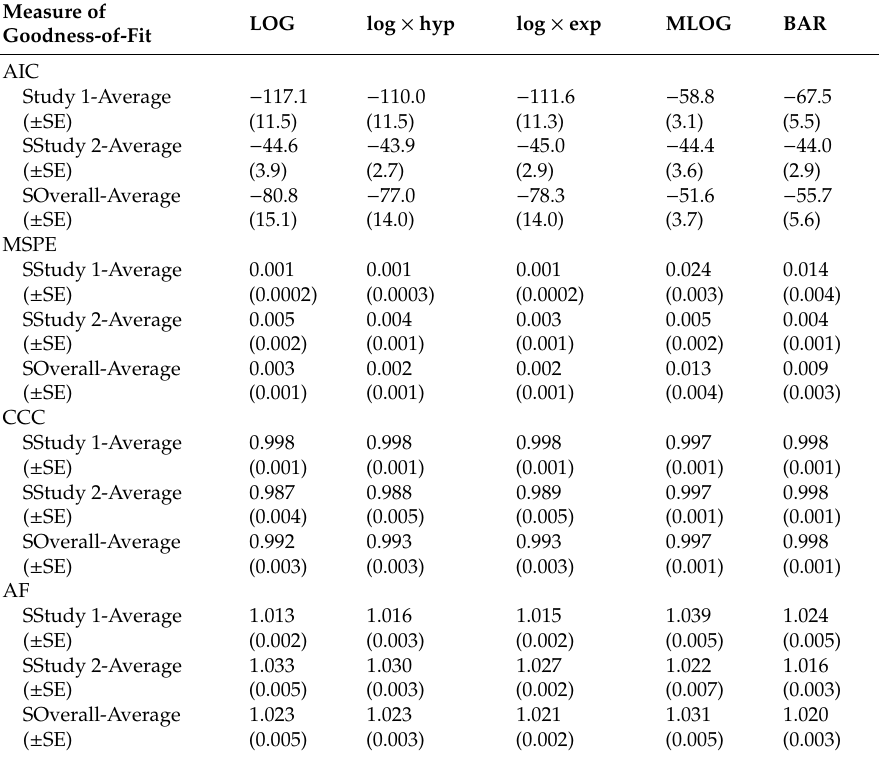
Table 3. Goodness-of- fit: Akaike information criterion (AIC), mean square prediction error (MSPE) concordance correlation coe ffi cient (CCC) and accuracy factor (AF) values obtained when fitting models to microbial growth data from Study 1 and